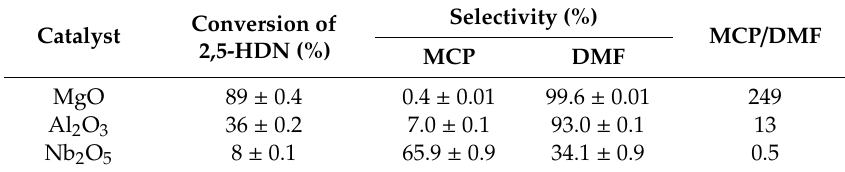
Figure 1. 2-Propanol decomposition at 350 °C. Table 1. The results of 2,5-hexanedione (2,5-HDN) cyclization at 350 °C.